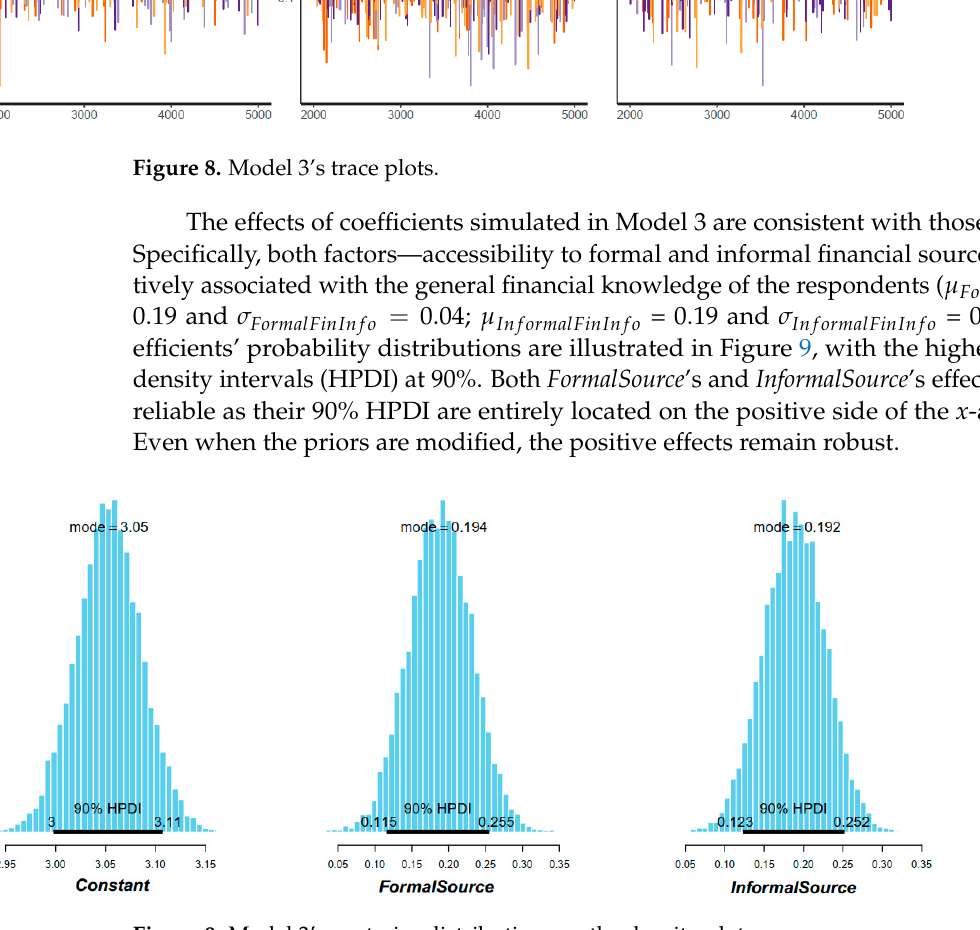
Figure 9. Model 3 ′ s posterior distributions on the density plot.